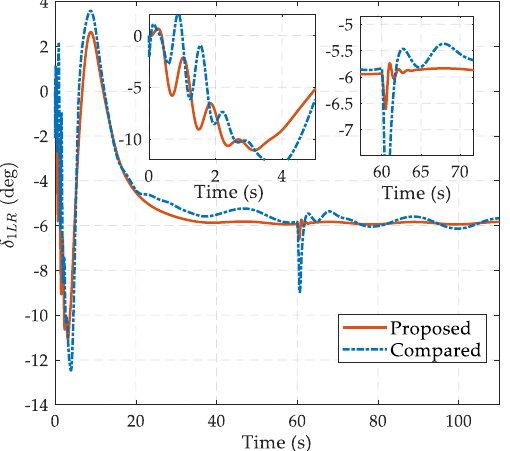
Figure 7. The curves of the deflection of control effector δ 1 LR in the comparative simulations.